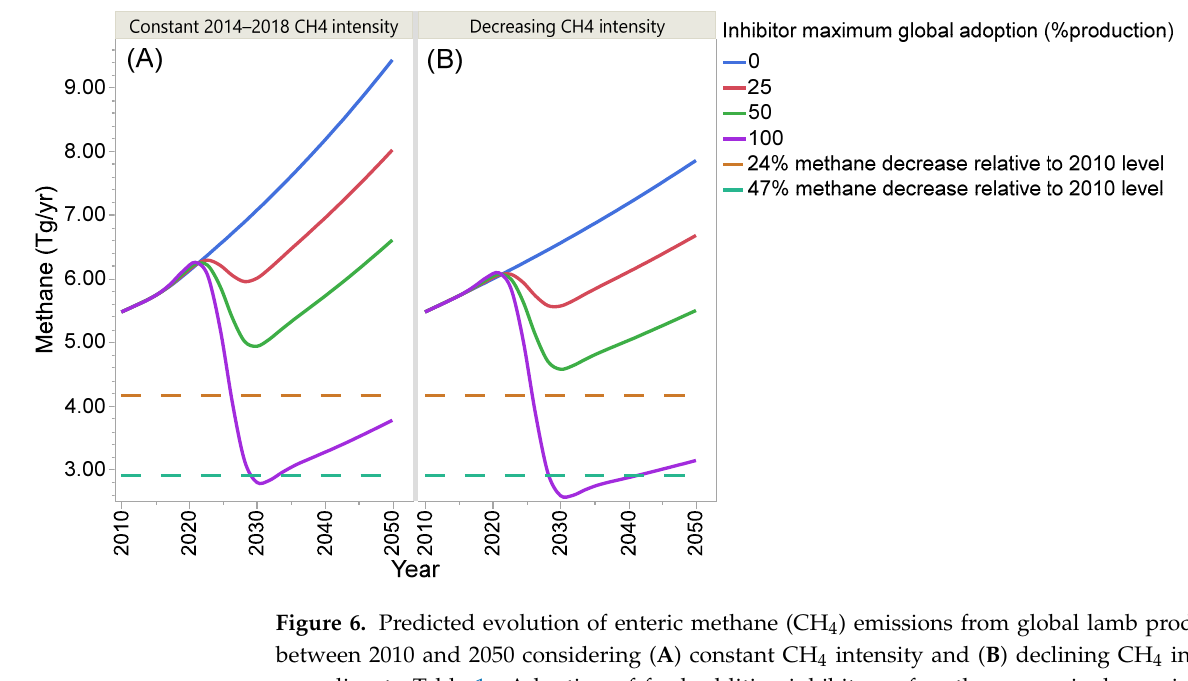
10 Figure 5. Predicted evolution of enteric methane (CH 4 ) emissions from global beef production be-